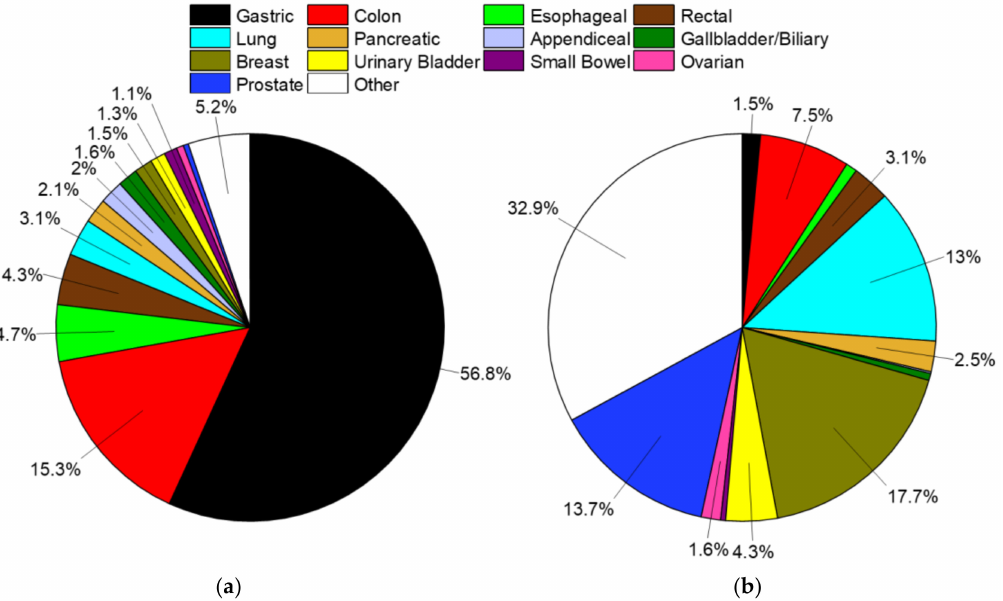
Figure 2. ( a ) Distribution of signet ring cell tumors in SEER, 1975–2016, total of 41,847 cases. ( b ) Distribution of all solid (non-blood borne), non-signet ring cell tumors in SEER, 1975–2016, total of 9.56 million cases. In both plots data labels are percentages. Markers omitted if less than 1%. To provide a visual overview across all cancer sites, Kaplan-Meier survival curves with 95% confidence intervals are also presented (Figure